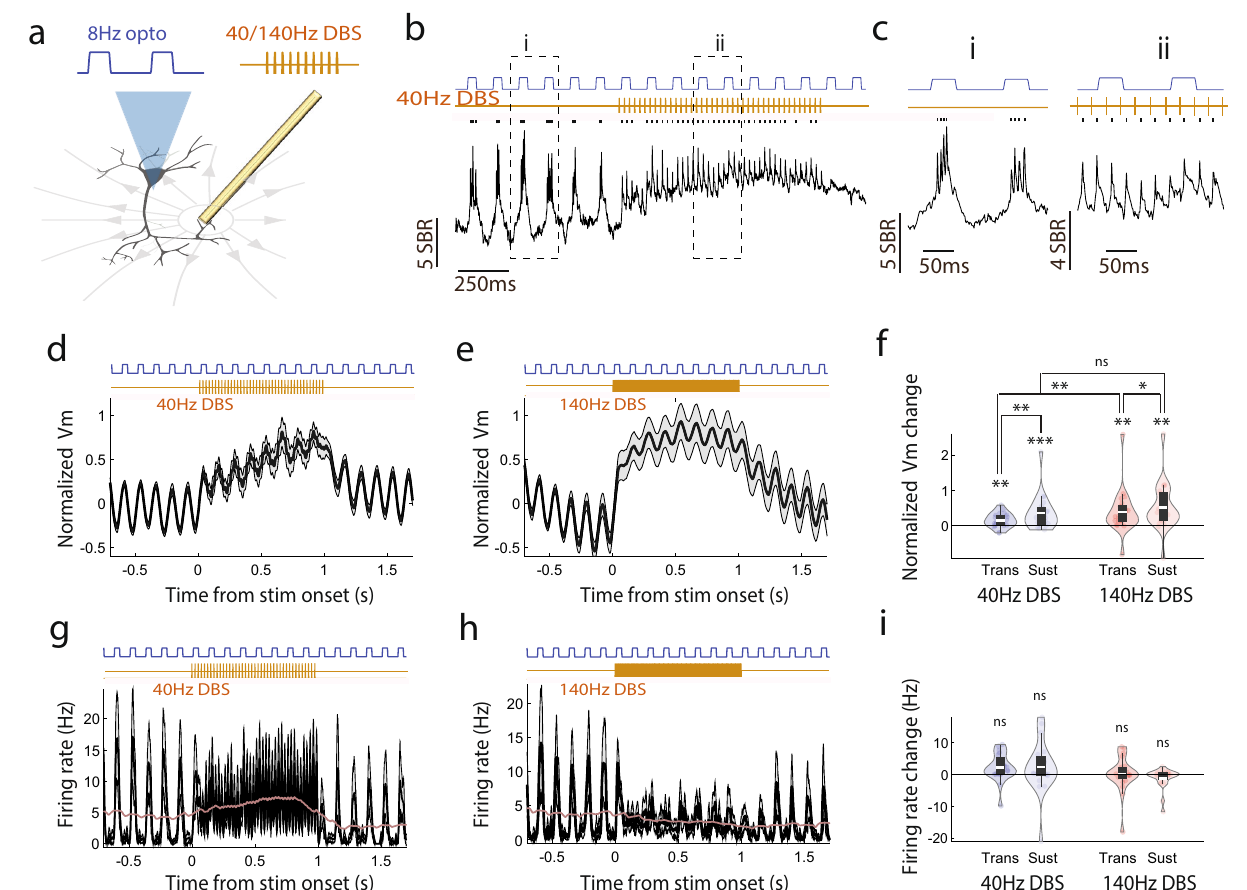
Fig. 5 | DBS evokes additional Vm depolarization without changing the spike rateinthepresenceofCoChRoptogeneticinputs.a Illustrationofsimultaneous CoChR-evoked membrane depolarization and SomArchon voltage imaging during DBS. Optogenetic blue light stimulation was delivered wide- fi eld over an area of 350 microns de fi ned by the 40x objective. Schematic neuron was adapted from scridraw.io (doi.org/10.5281/zenodo.3925905). b An example CA1 neuron ’ s SomArchon fl uorescence trace (black) and spikes (black ticks) during 8Hz CoChR activation (blue line) and 40Hz DBS (gold line). 8Hz CoChR activation occurred throughout the 3-second trial, whereas 40Hz DBS occurred for 1second in the middle of each trial. c Zoom-inview of the periodsindicatedbythe dashed lines in (b), during the baseline (i) and the DBS period (ii). d Population-averaged Vm during simultaneous 8Hz optogenetic activation (blue) and 40Hz DBS (gold). Vm is calculated as the fl uorescence at each time point divided by the average ampli- tude of all spikes detected in a recording session for a given neuron ( n =20). DBS- inducedVmchangeswerecomputedasnormalizedVmbysubtractingthemeanof the Vm during the pre-stimulation baseline period. Shaded area represents SEM. e Same as ( d ), but with 140Hz DBS ( n =21). f Quanti fi cation of the transient (0 – 0.15sec) and the sustained (0.15 – 1sec) Vm depolarization induced by either 40Hzor140HzDBS,inthepresenceof optogeneticactivation.Dataarevisualized as violin plots with the outer shape representing the data kernel density and a box